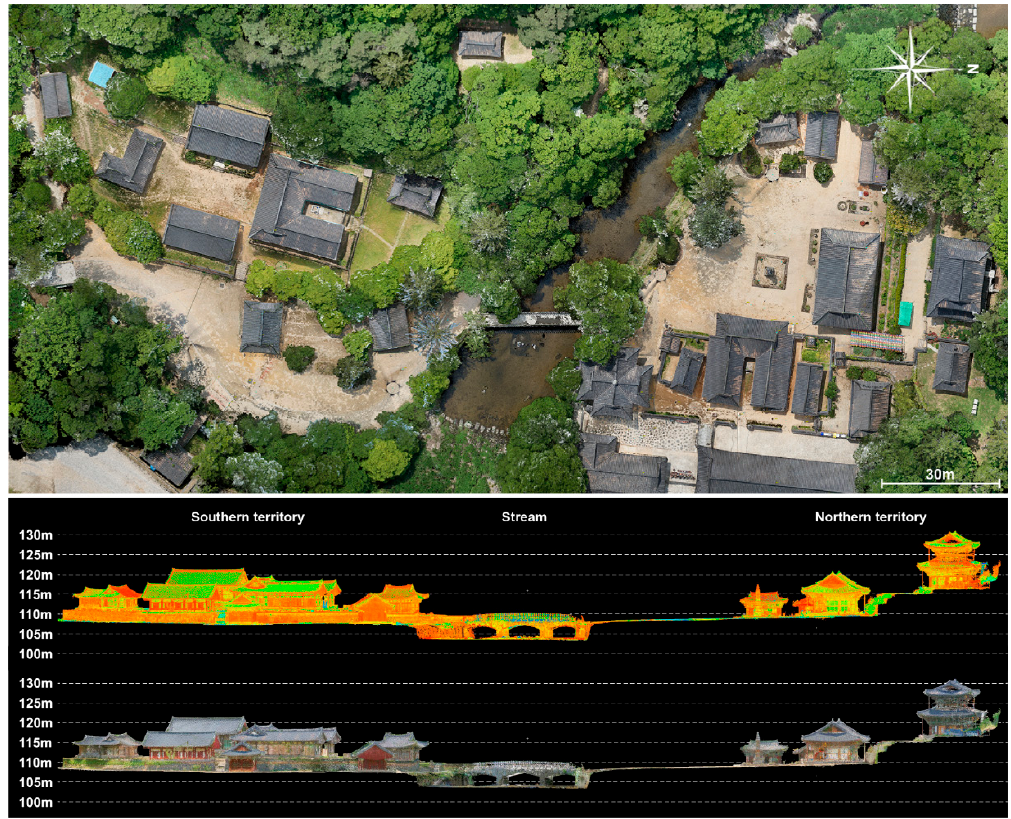
Figure 10. True orthoimage and cross-section of Magoksa Temple’s terrain.